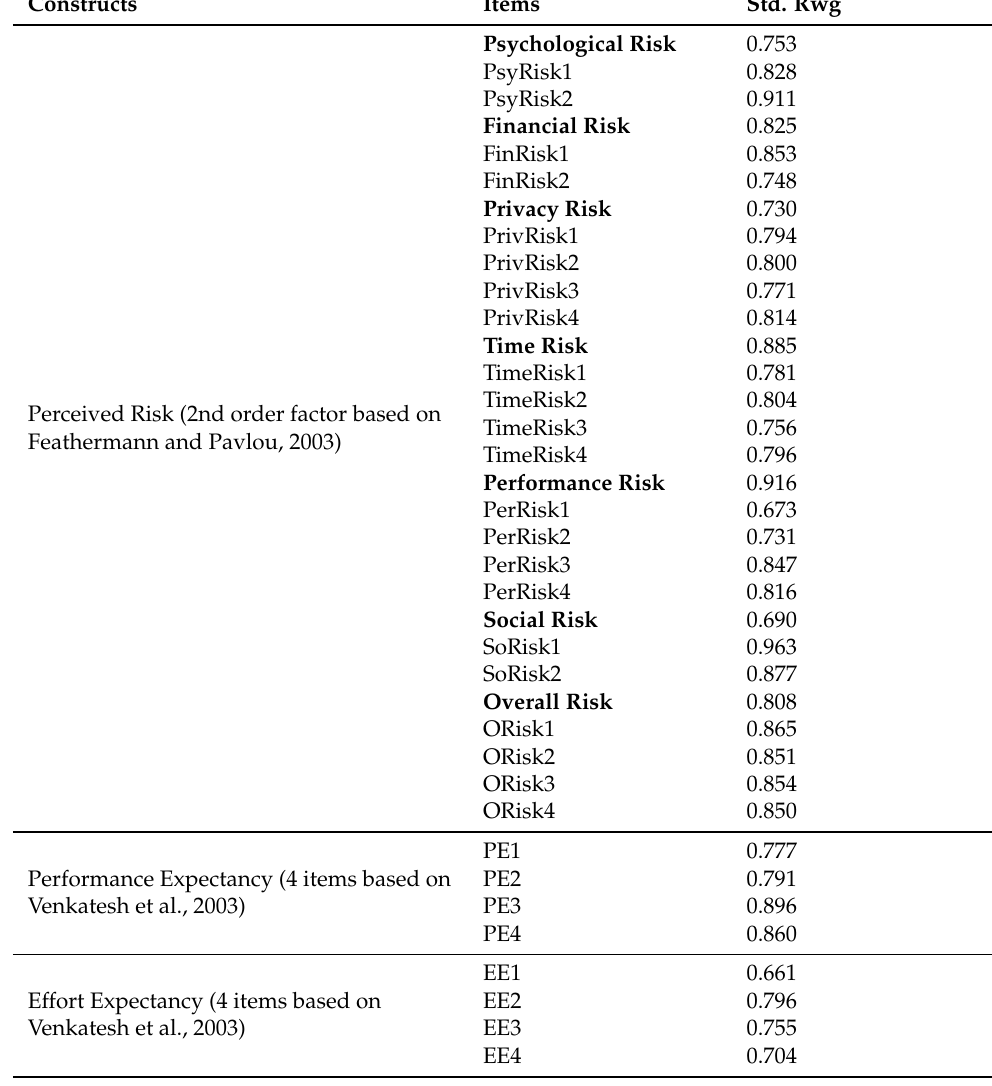
Table 1. Factor loadings for the measurement